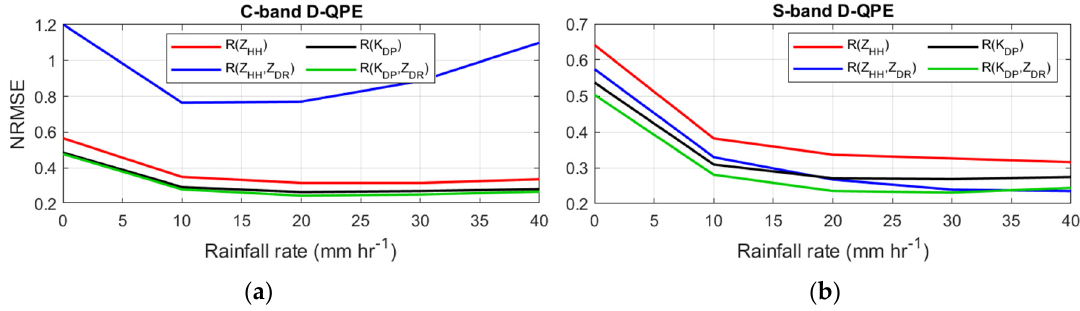
Figure 8. The NRMSE of D-QPEs as a function of rainfall rates for ( a ) C-band and ( b ) S-band D-QPEs.